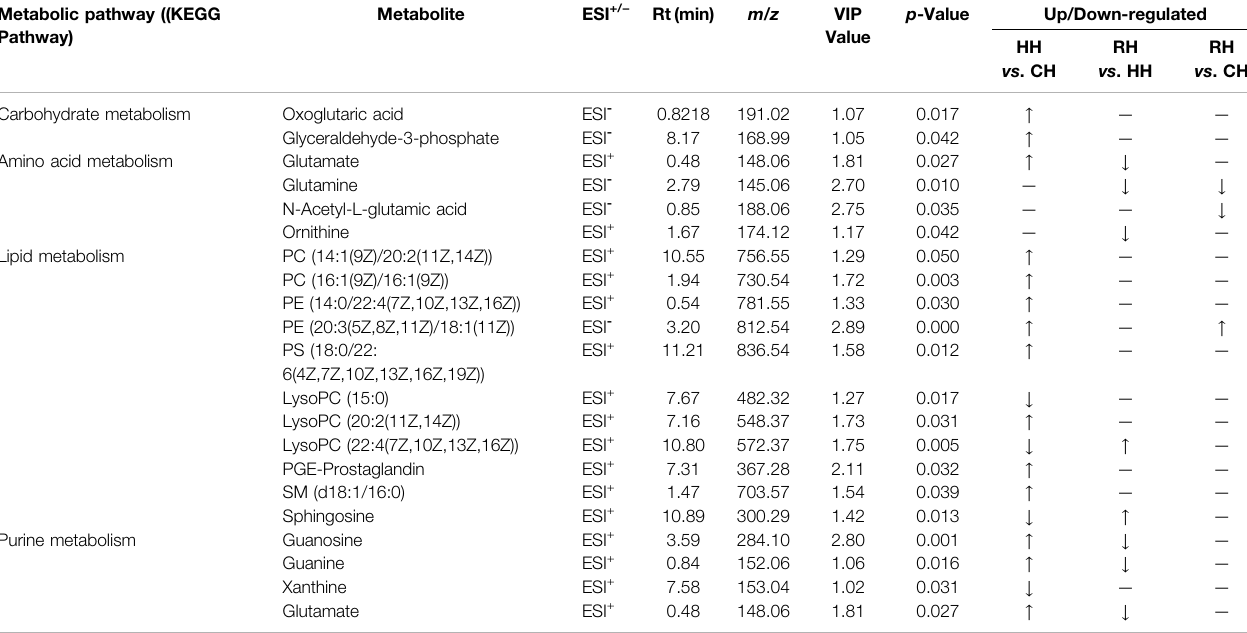
TABLE 1 | Signi fi cantly different metabolites. Metabolic pathway ((KEGG Pathway)